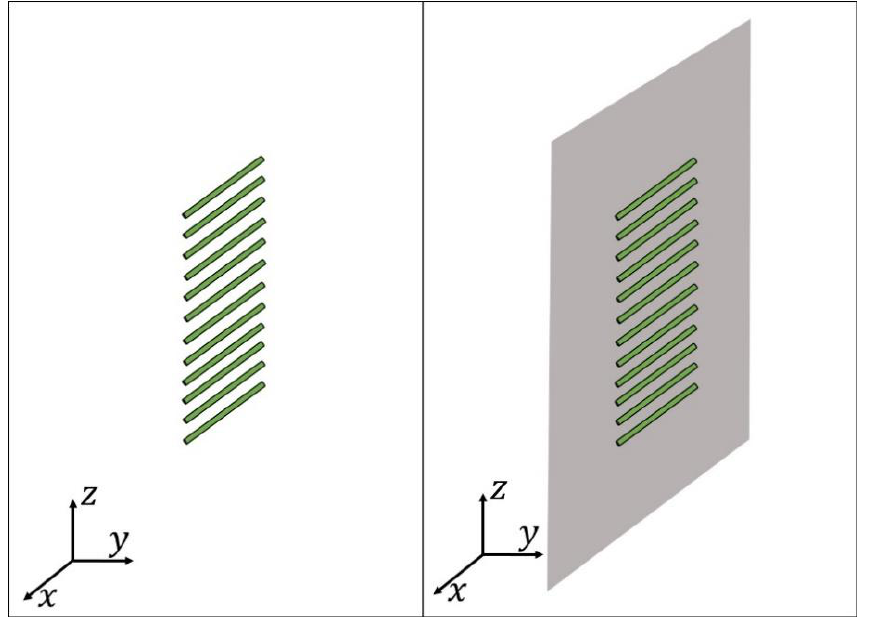
Figure 3. Sketch of the proposed 12-element linear array for the real pattern case (RPC): in absence of ground plane ( left ), in presence of ground plane ( right ).